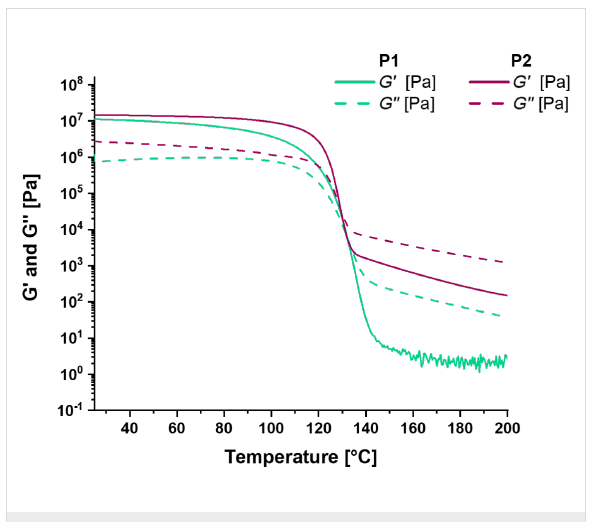
Figure 2: DMTA analysis of P1 and P2 showing the transition at around 130 °C due to the reversible π – π